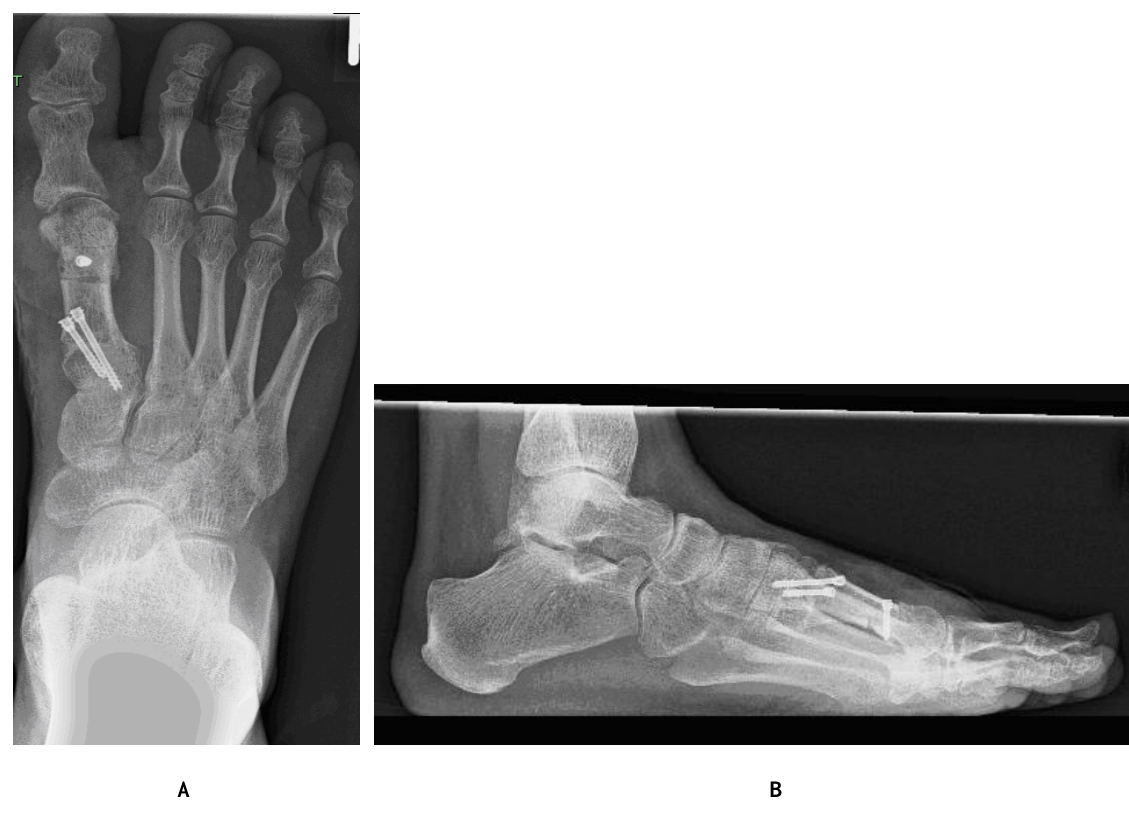
FIGURE 3. Three-month postoperative weight bearing of foot; anteroposterior view (A) and lateral view